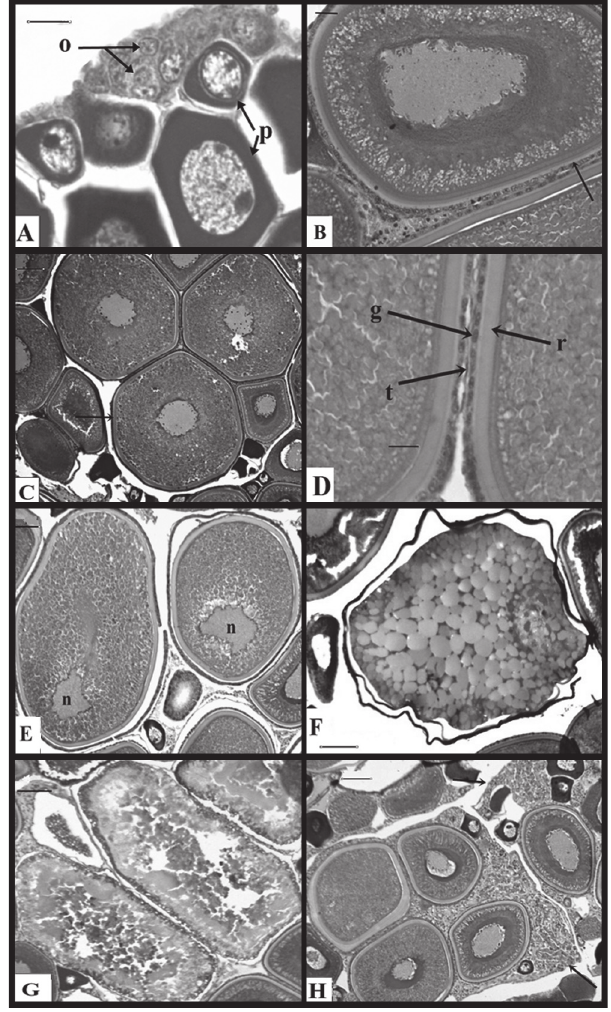
Fig. 4. Stages of oocyte development of Anchoa marinii .